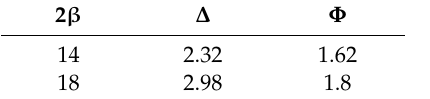
Table3. Thecalculatedredundantworkfactor Φ asafunctionof ∆ and2 β Table 3. The calculated redundant work factor Φ as a function of Δ and 2β used in numerical simulations.